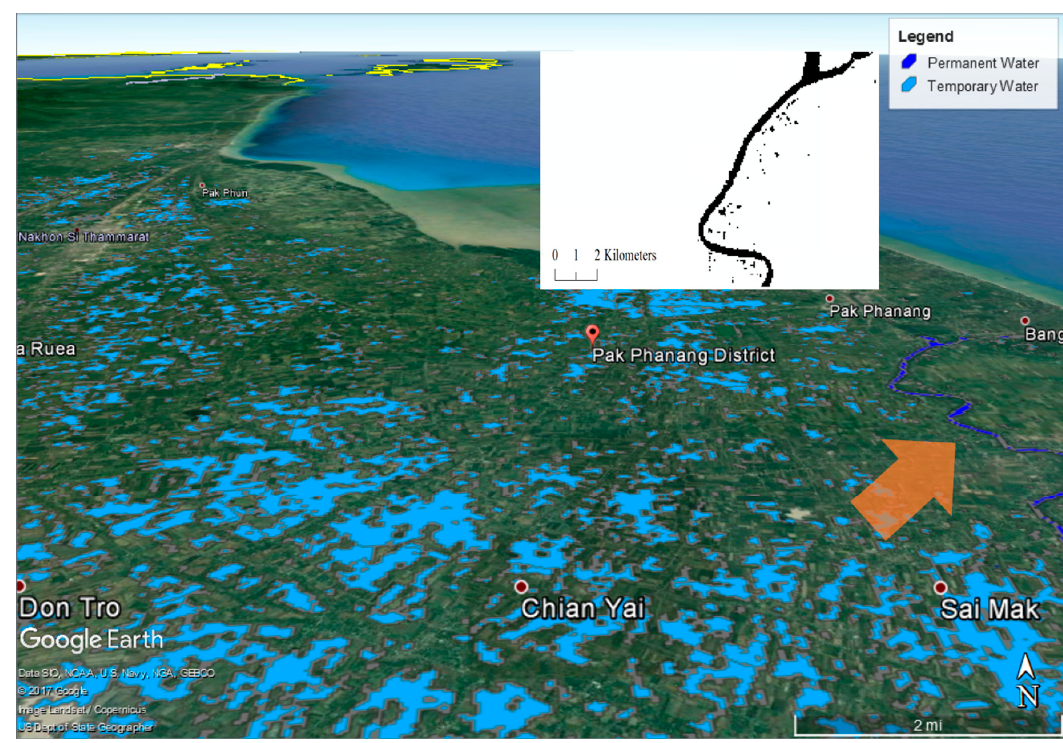
Figure 10. Discrimination between the Lang Suan River in dark blue and the flooded areas in light blue in the Lang Suan district, Chumphon.